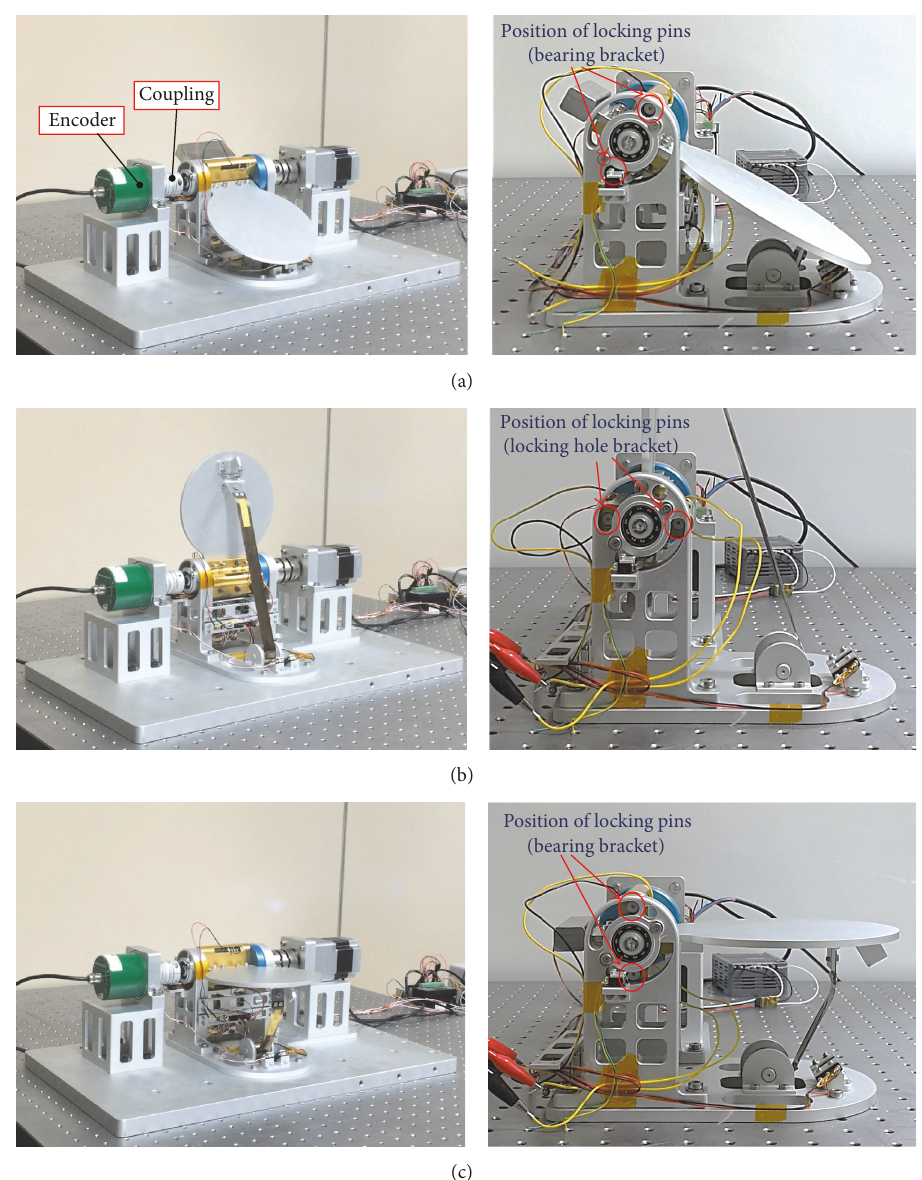
Figure 6: Example of operational function test results ((a) stowing mode, (b) deploying mode, and (c) fail-safe